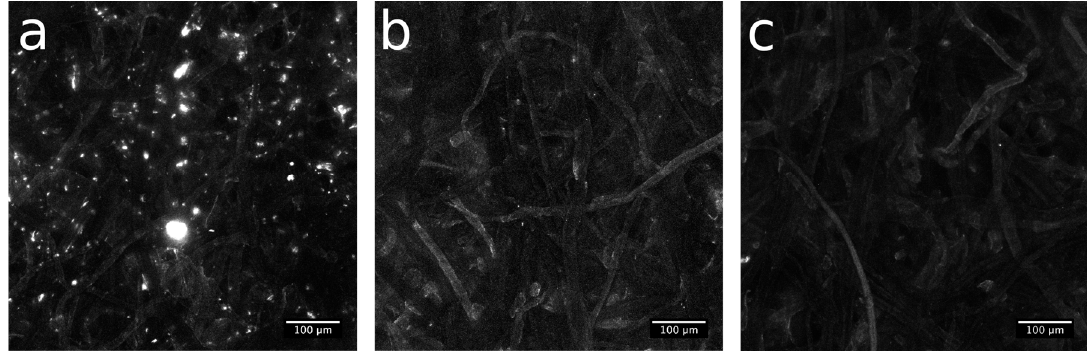
Figure 7. Confocal microscopy image of ( a ) Paper-NBB80h , ( b ) Paper-NBB80h click 15’, and ( c ) Paper- NBB80h click 30’ samples after CPM treatment.